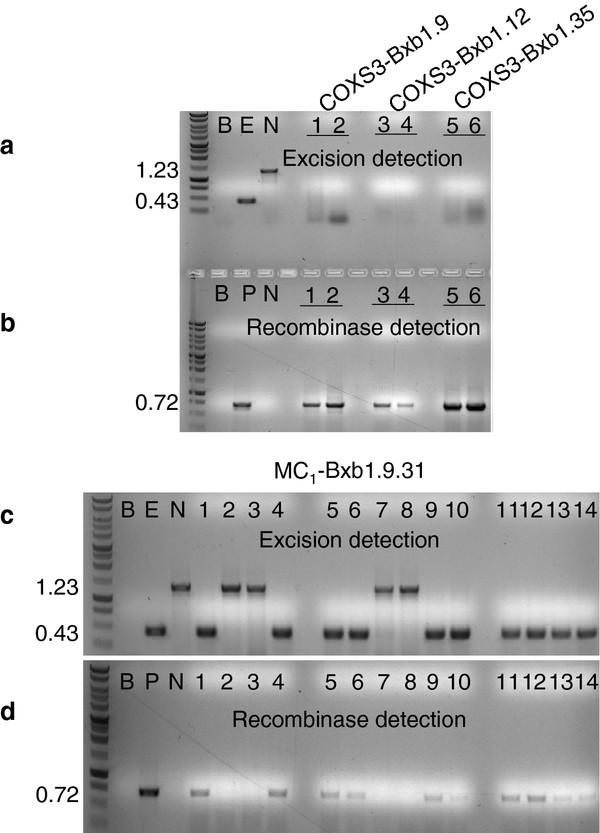
PCR analysis for site-specific recombination and the presence of the recombinase gene the manual cross (MC1) generation. PCR reactions (a, c) with primers e and f or (b, d) with primers g and h on representative plant DNAs. a, b) Segregated lines (lanes 1, 2) S1-Bxb1.9; (lanes 3, 4) S1-Bxb1.12; (lane 5, 6) S1-Bxb1.35; (lane 7, 8) S1-Bxb1.28 negative for excised target but positive for Bxb1 gene. As target line TA3-Bxb1.28 appears to be homozygous no Bxb1 expression lines were derived from the retransformation event. c, d) MC1-Bxb1.9.31 with predicted, excision events (0.43 kb) only appearing in lanes when the recombinase gene is present (0.72 kb). Control lanes are B (blank, no DNA); E (excision, pN6-Bxb1exc DNA); N (no excision, pN6-Bxb1); P (pCOXS3-Bxb1).